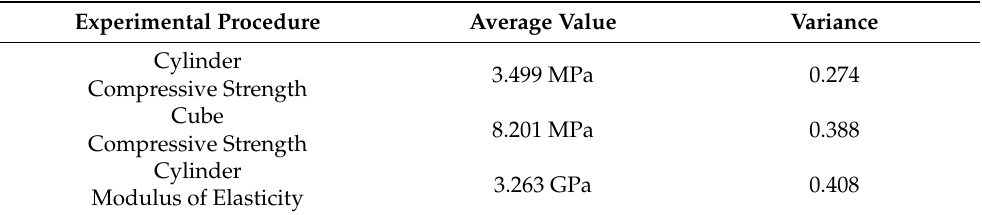
Table 2. SFRRC Static loading under Compression Results per Experimental